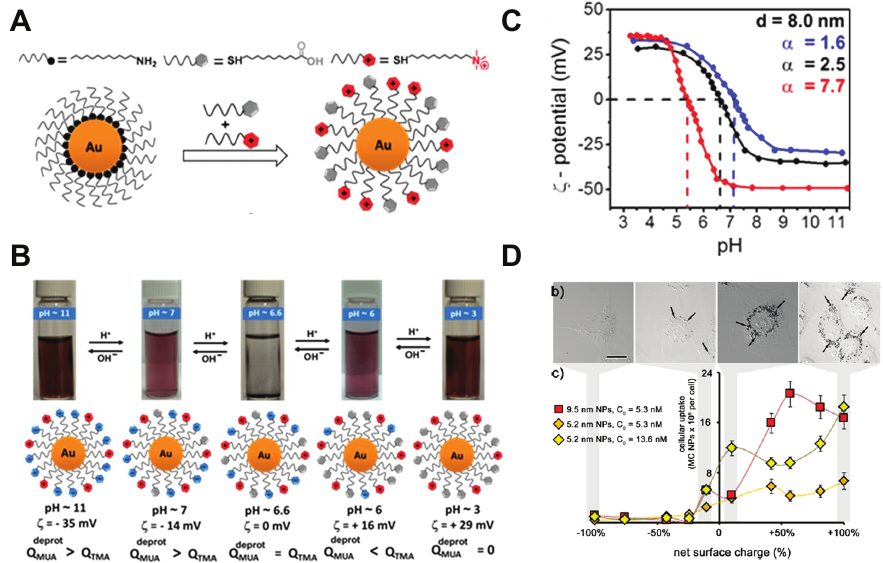
Figure 4. Properties of pH-responsive polymer-decorated NPs and their influence on cellular uptake efficiency. ( A ) Schematic of ligand exchange reaction between dodecylamine (DDA) NPs and mercaptoundecanoic acid (MUA), N , N , N -trimethyl(11-mercaptoun decyl)ammonium (TMA) ; ( B ) Images of solution under various pH values, containing 8.0 nm mixed-charged (MC) NPs with α surf = 2.5. The MC NPs would be stable except at pH value 6.6. The scheme in the lower part illustrates the corresponding surface charge of the MC NPs, and it became zero net charge at pH value 6.6; ( C ) Plot of the changes of the ζ potential on the MC NP’s surface, relating to the solvent pH value and the ligand composition α surf . The diameter of the NP core was 8 nm; ( D ) Optical images of Rat 2 cellular uptake, indicated by the arrows. The cellular uptake increases with increasing net surface charge. The figures are adapted from Reference [55] with